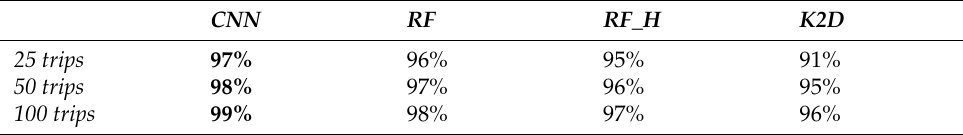
Table 4. Test accuracy for the 12 models.